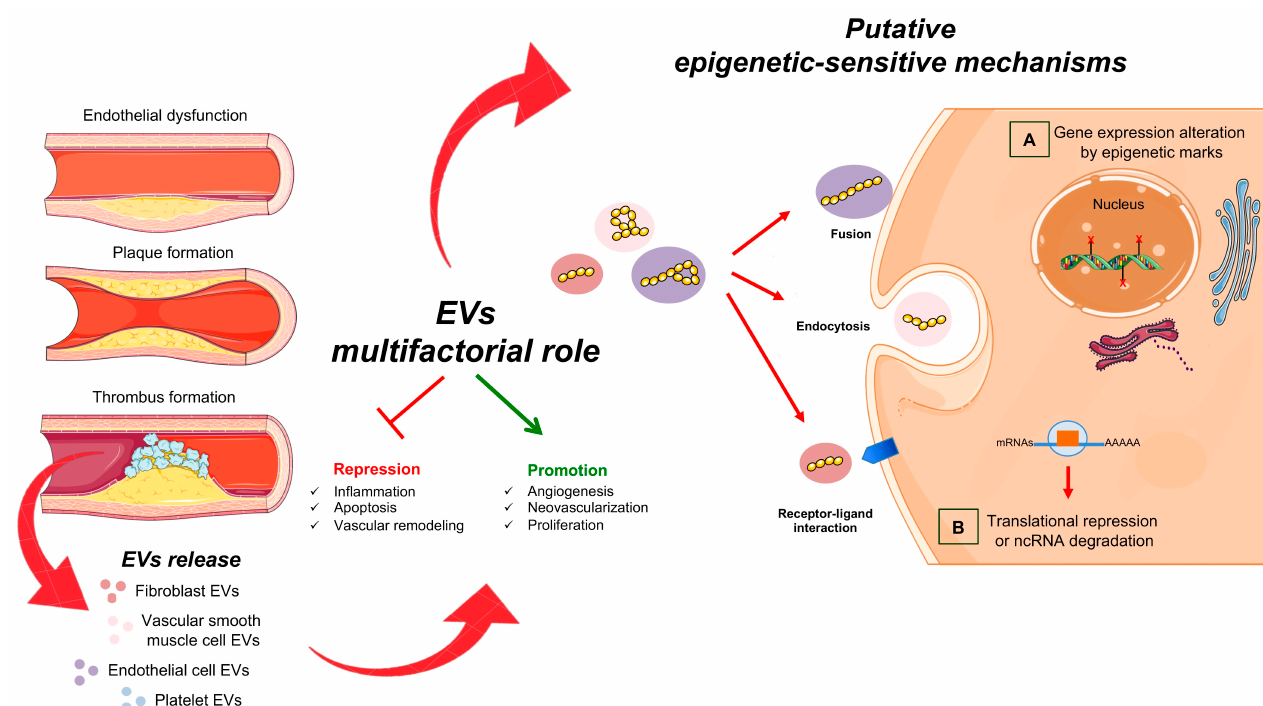
Figure 1. Extracellular vesicles and vascular damage. Schematic representation of atherosclerotic EVs. They are produced by the different cell types involved in the mechanism of plaque formation. Harmful EVs can promote atherogenesis by altering vascular integrity, increasing inflammatory response and promoting thrombus formation. On the other hand, beneficial EVs, containing specific ncRNAs, can play athero-protective roles by promoting the repair of damaged endothelium and repressing the activation of inflammatory cells. The EVs interact with target cells via direct fusion, endocytosis or the binding of surface proteins. After this invagination, cytosolic proteins or RNA content-EVs transfer to the extracellular space. In the target cells, ncRNAs (such as lncRNAs, miRNAs, circRNAs) can (A) control nuclear gene expression via epigenetic changes and/or (B) affect protein function.